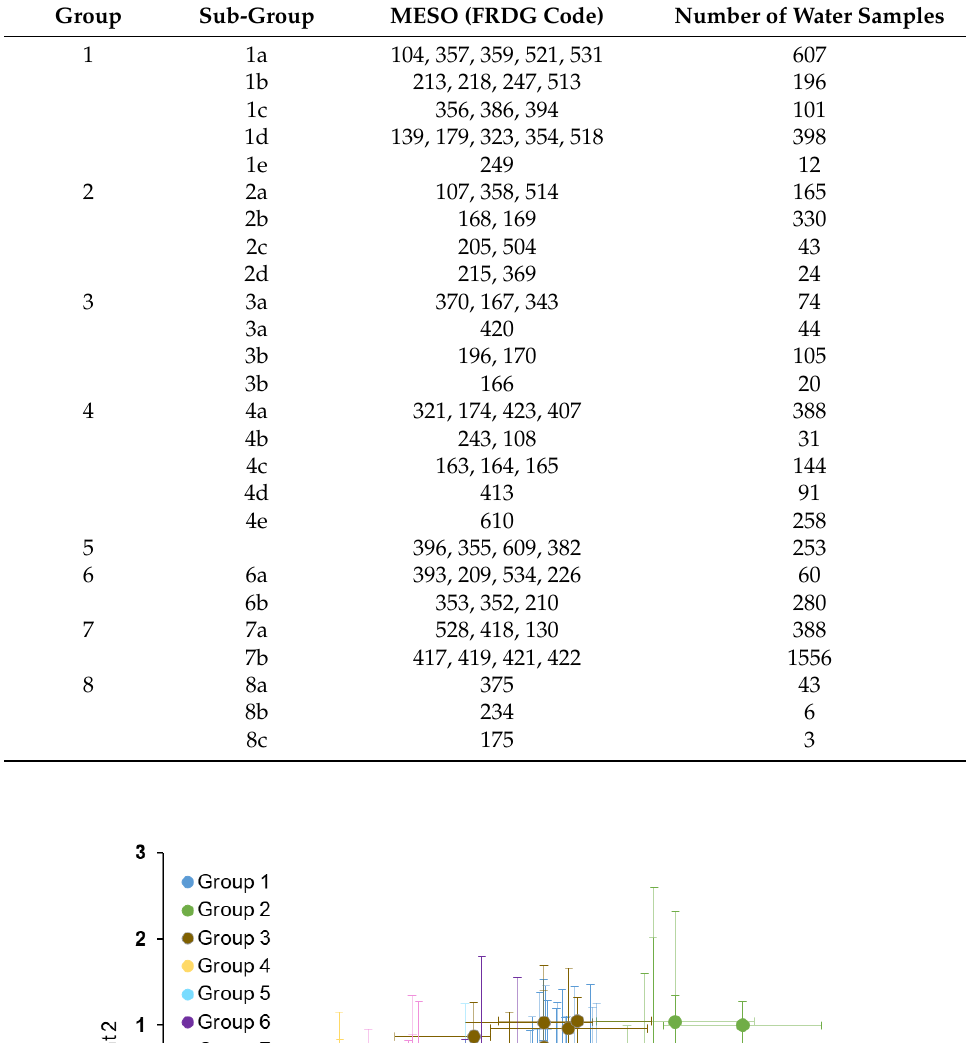
all parameters taken together. Within groups, the dissimilarities between sub-groups are between 0.5 and 2. Table 2. Groups and subgroups of MESO resulting from unsupervised hierarchical cluster analysis (HCA) based on mean values on first 11 PCs.